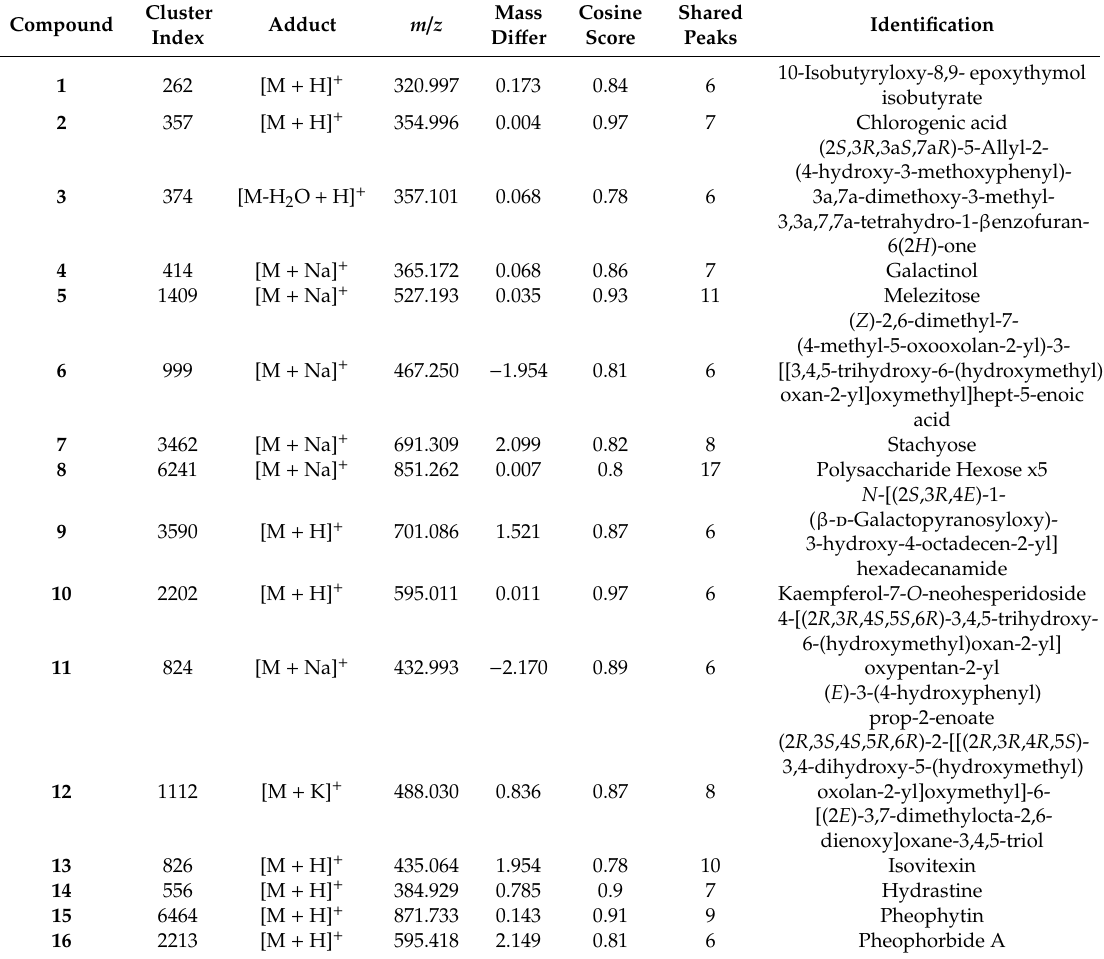
Table 2. The hits in precursor tolerance against the GNPS